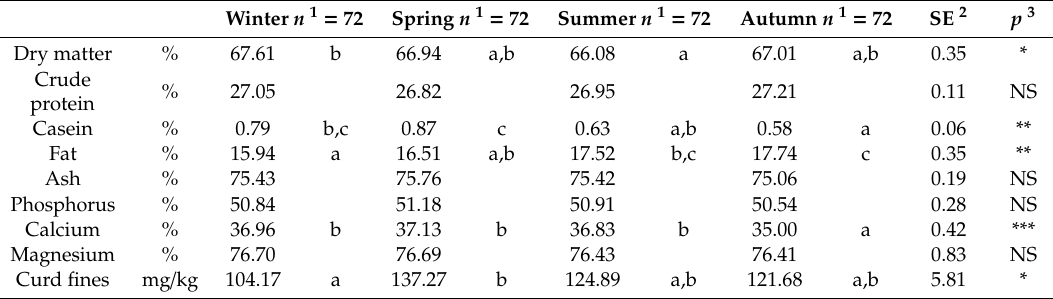
Table 3. Seasonal variation of estimated cheese-making loss values and curd fines (least square means